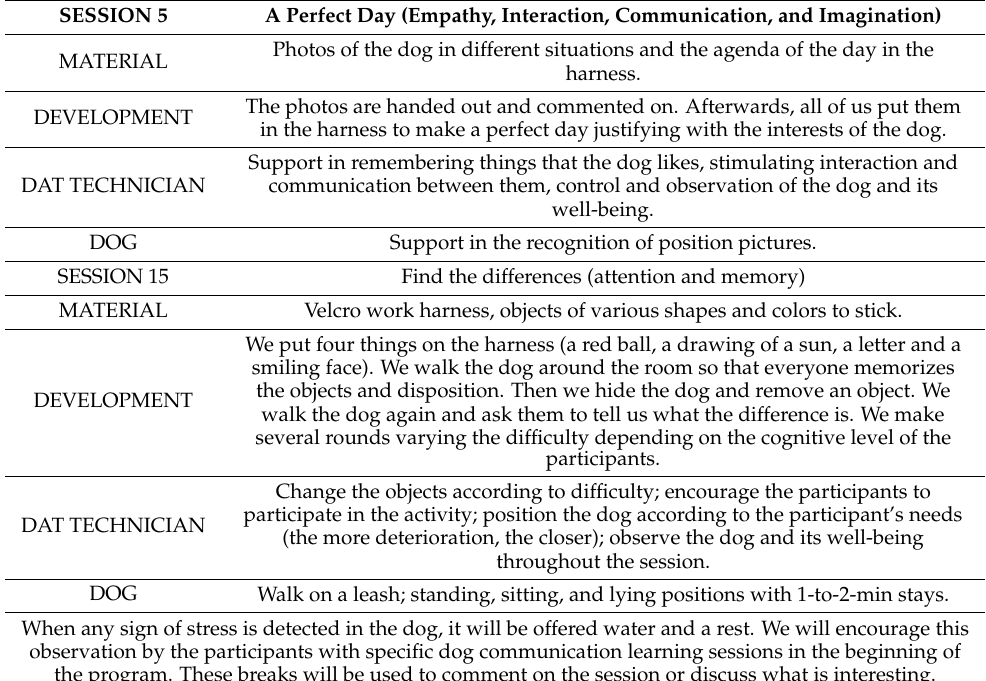
Table A2. Sample